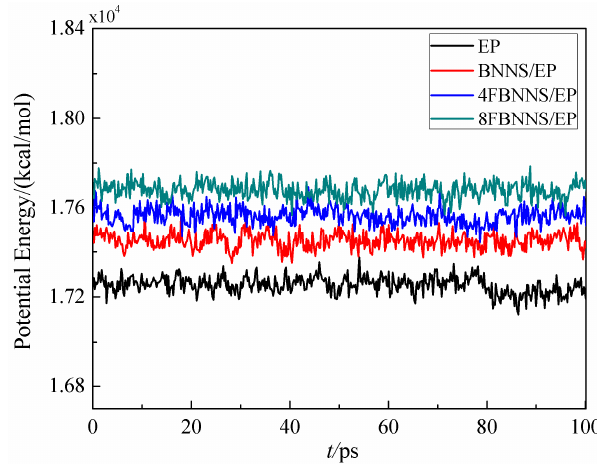
Figure 7. Potential energy of BNNS/EP nanocomposites for 100 ps. Appl. Sci. 2019 , 9 , x FOR PEER REVIEW